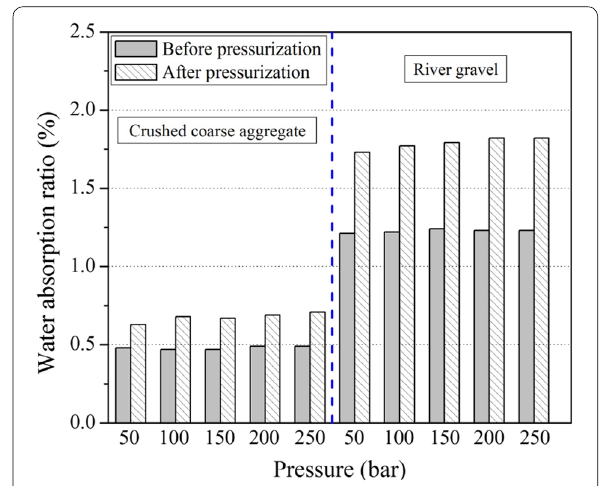
Fig. 12 Results of water absorption ratio before and after pressurization (Choi et al.